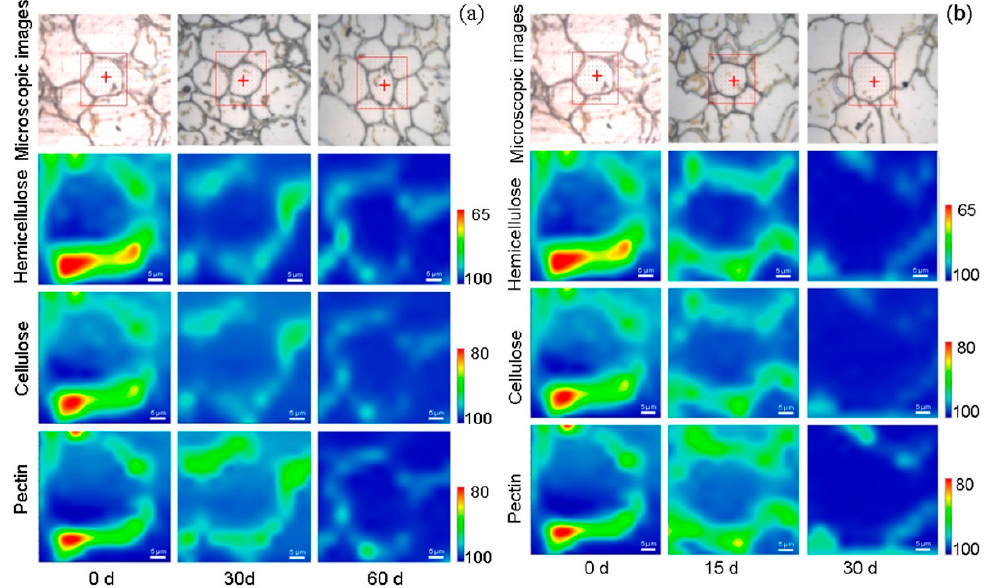
Figure 3. FTIR hyperspectral images of cell wall in peach parenchyma tissue during the postharvest at 0 ◦ C ( a ) and 20 ◦ C ( b ). Spectral images from 1030 cm − 1 to 1050 cm − 1 , from 1230 cm − 1 to 1250 cm − 1 , and from 1740 cm − 1 to 1760 cm − 1 were showed the distribution of hemicellulose, cellulose and pectin, respectively. The red squares on the microscope images mark the measurement areas. Since 0 d is the starting point of the postharvest storage, images of 0 ◦ C and 20 ◦ C at 0 d were the same as they were obtained from the same